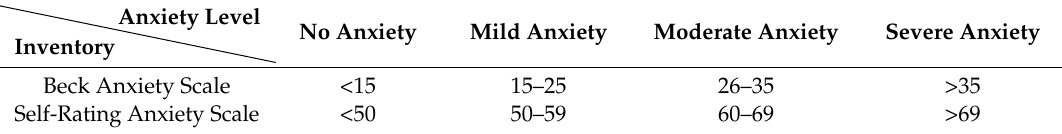
Table 2. The levels of anxiety in the Baker Anxiety Inventory and Self-rating Anxiety Scale. InventoryAnxiety Level No Anxiety Mild Anxiety Moderate Anxiety Severe Anxiety Beck Anxiety Scale <15